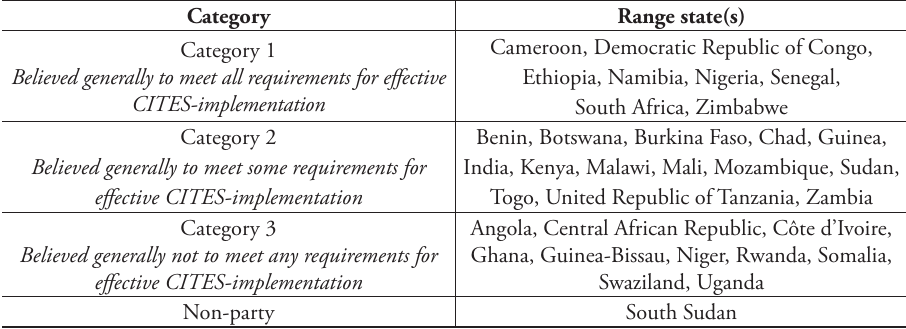
Table 7. Status of CITES implementation legislation. Data from http://www.cites.org/eng/legislation, last updated